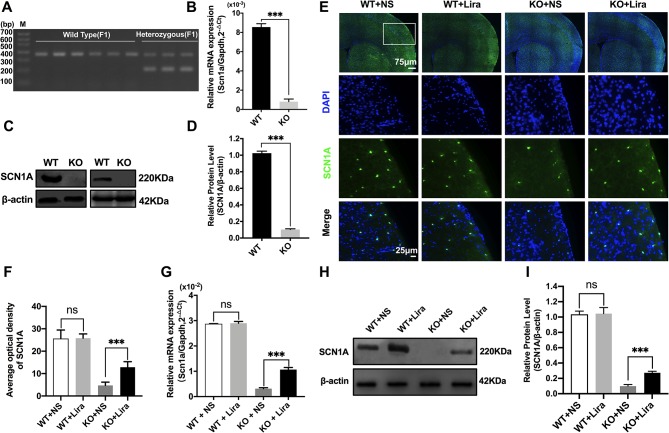
Phenotype verification of Scn1a KO mice and the increase of SCN1A expression after liraglutide treatment in the brain of Scn1a KO mice. (A) PCR was used to identify wild-type and Scn1a KO heterozygous (F1) genotypes. (M: DNA marker). (B) RT-qPCR analysis of the Scn1a mRNA expression from brains of wild-type (WT) and Scn1a KO heterozygote (KO) mice (N = 24 mice per group; Student’s t-test, P < 0.001). (C) Representative western blotting showing SCN1A protein expression in brains of WT and Scn1a KO mice. (D) Summary graph of western blotting analysis demonstrating a significant reduction in the SCN1A protein in brains of Scn1a KO as compared to WT mice (N = 24 mice per group; Student’s t-test, P < 0.001). (E) Representative images of immunofluorescent staining with SCN1A (green), and DAPI (blue) in the ipsilateral side of the cortex of the WT and Scn1a KO mice. Scale bar: 75 μm for the full-scale images and 25 μm for the magnified images. (F) Summary graph of the average optical density of SCN1A fluorescent staining measured in images (E) demonstrating a profound increase of SCN1A in the cortex of Scn1a KO mice after liraglutide administration (N = 24 mice per group; Student’s t-test, P < 0.001). (G) RT-qPCR analysis of the SCN1A mRNA expression after liraglutide administration in brains of WT and Scn1a KO mice (N = 24 mice per group; One-way ANOVA, Student’s t-test). (H) Representative western blotting showing SCN1A protein expression in brains of the WT and Scn1a KO mice. (I) Summary graph of western blotting analysis demonstrating a dramatic increase in the SCN1A protein from brains of Scn1a KO after liraglutide administration (N = 24 mice per group; One-way ANOVA, Student’s t-test). The relative expression of SCN1A was normalized to reference controls Gapdh and β-actin in RT-qPCR and Western blotting, respectively. Data were presented as mean ± SD; ***, P < 0.001; ns, not significant. All experiments were performed in triplicate. WT, Wild-type; KO, Scn1a Knockout heterozygotes (F1); NS, Normal saline; Lira, Liraglutide.